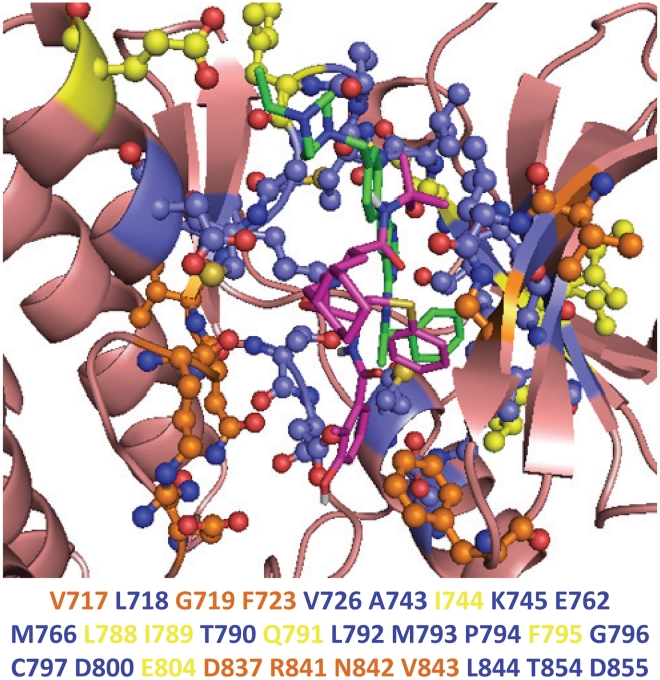
Overlap between EGFR ATP binding sites and Nelfinavir binding sites predicted by SMAP.The wheat cartoon represents the backbone structure of EGFR (PDB id: 2J6M). Green sticks represent the co-crystal ligand of EGFR (PDB ligand id: AEE). Magenta sticks represent superimposed Nelfinavir on EGFR according to SMAP alignment. Yellow sticks and balls represent the AEE binding site of EGFR. Orange sticks and balls represent the predicted Nelfinavir binding site for EGFR. Blue sticks and balls represent the overlap between the AEE binding site and the predicted Nelfinavir binding site for EGFR. The amino acid residues involved in the binding site are listed below the structure, colored accordingly.